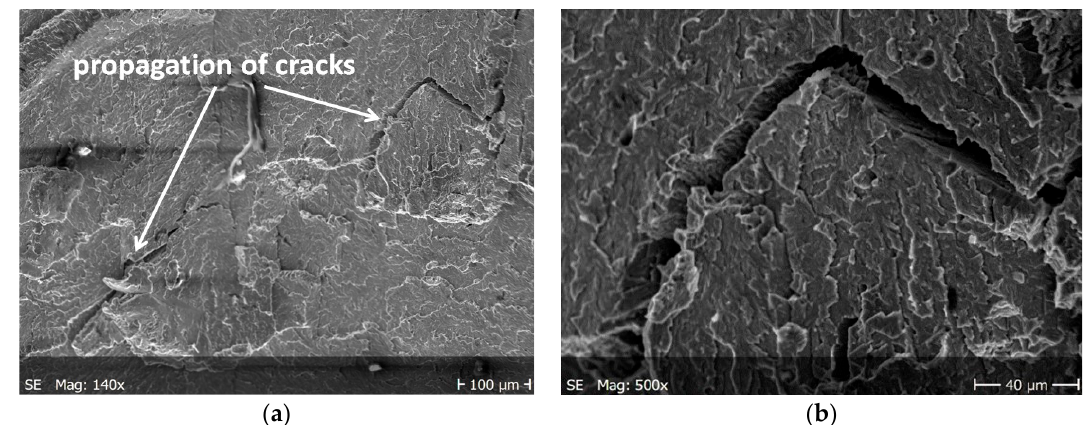
Figure 12. Cracking of O–Ti 2 AlNb alloy in specimen after cyclic tests for; ( a ) a larger specimen area, ( b ) enlarged crack. Materials 2020 , 13 , x FOR PEER REVIEW